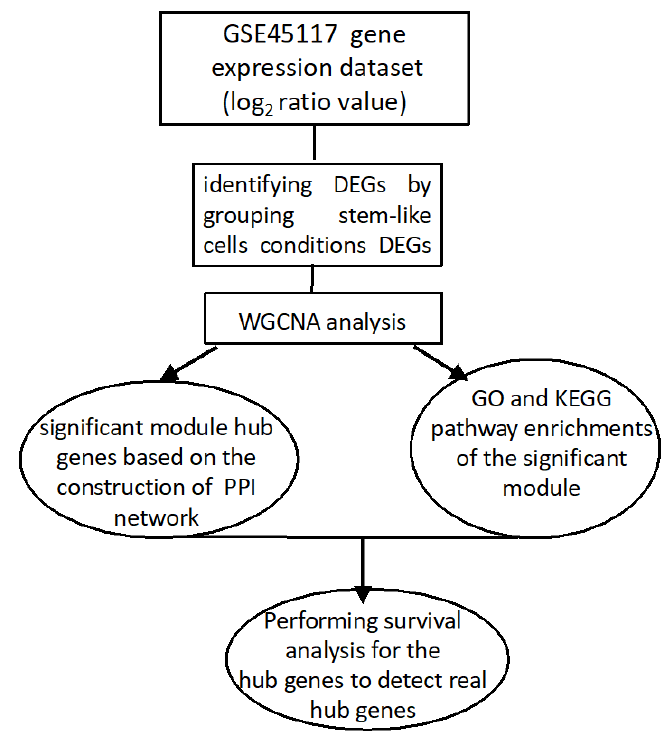
Figure 1. A design of the computation steps of the GSE45117 gene expression dataset.